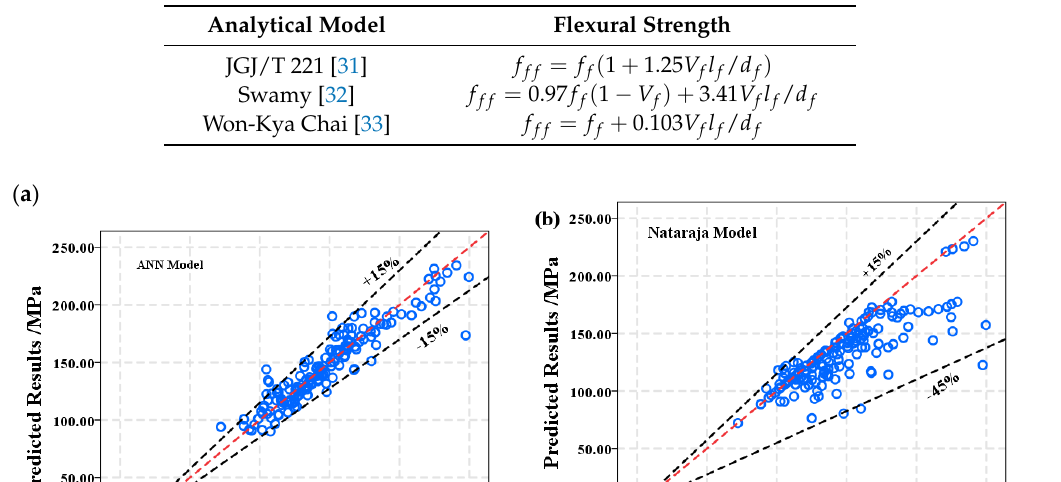
Table 9. Analytical models for predicting the Flexural strength of SFRC.